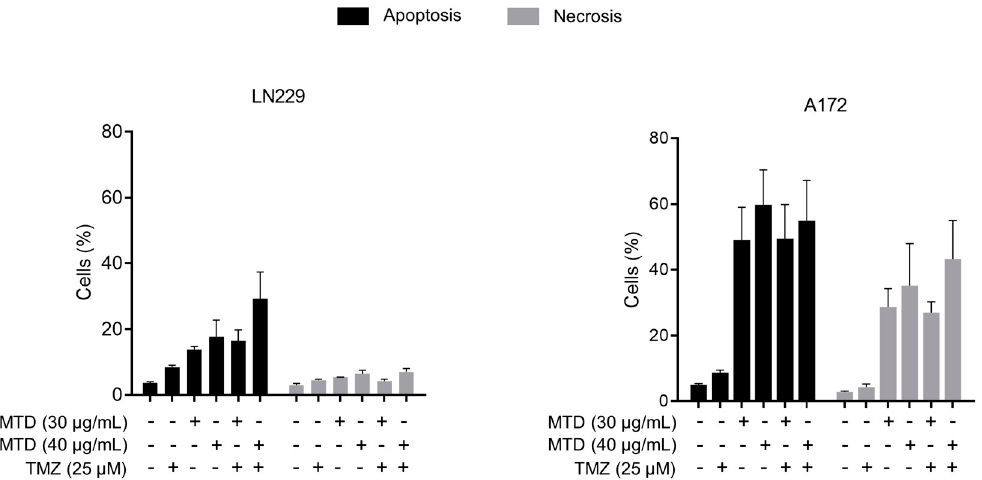
Figure 6. Effect of TMZ on MTD-induced apoptosis/necrosis in LN229 and A172 cells, measured 72 h and MTD-TMZ were in both cell lines not after treatment. Data are the mean of three independent experiments. The differences between MTD and MTD-TMZ were in both cell lines not significant.